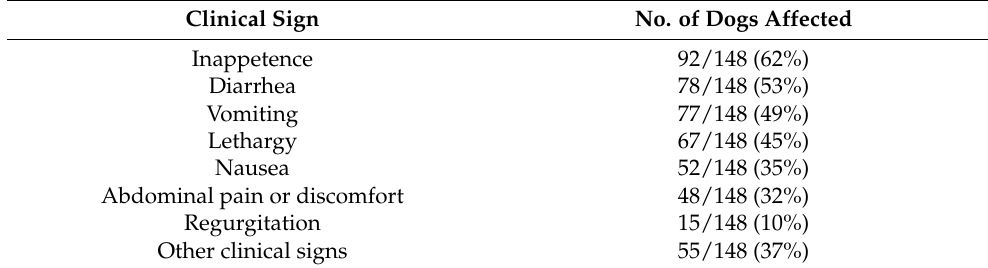
Table 3. Clinical signs reported in returned survey data from dogs with a serum cPLI ≥ 400 µ g/L. Clinical